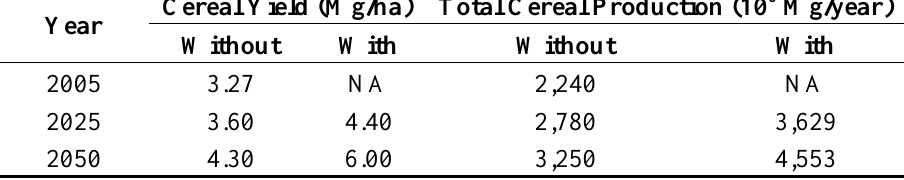
Table 1. Required cereal yield and total production to meet future food demand (adapted from